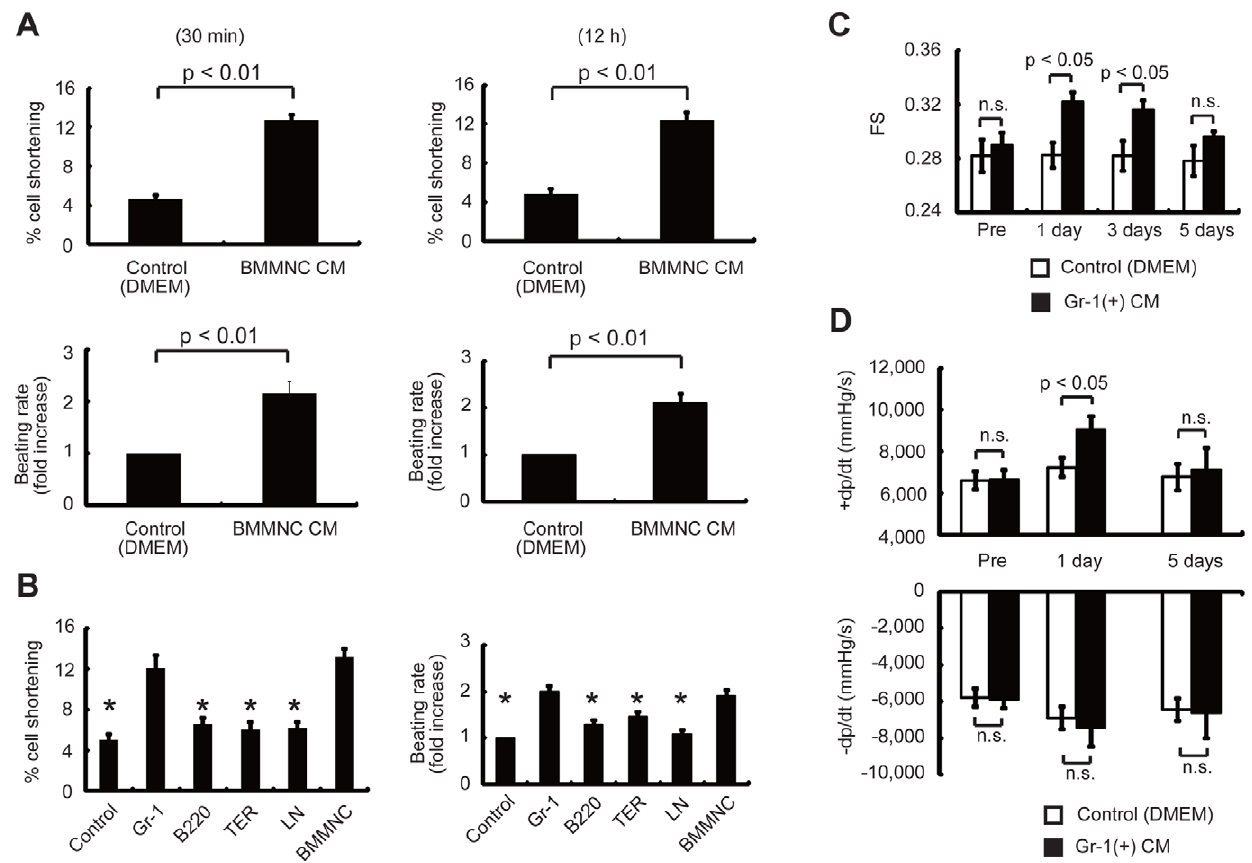
Figure 3. BMMNC-derived CM directly affects cardiomyocyte contractility. (A) Cell shortening and the beating rate of neonatal rat cardiomyocytes were significantly increased after exposure to CM from BMMNC compared with the control ( n =26 cells per group). The left and right graphs show the results at 30 min and at 12 h after treatment, respectively. Upper graph, cell shortening. Lower graph, beating rate. (B) CM from Gr- 1( + ) cells improved the cell shortening and increased the beating rate similar to that achieved by CM from BMMNC ( n =27 per group). (C, D) Effects of CM from Gr-1 cells on cardiac function in vivo . (C) Echocardiographic analysis ( n =7). The infusion of CM from Gr-1( + ) cells significantly improved the FS of DOX mice at 1 and 3 d. (D) Infusion of CM from Gr-1( + ) cells significantly improved the + dp/dt of DOX mice at 1 d, in vivo ( n =7). n.s., not significant. Data are means 6 s.e.m.